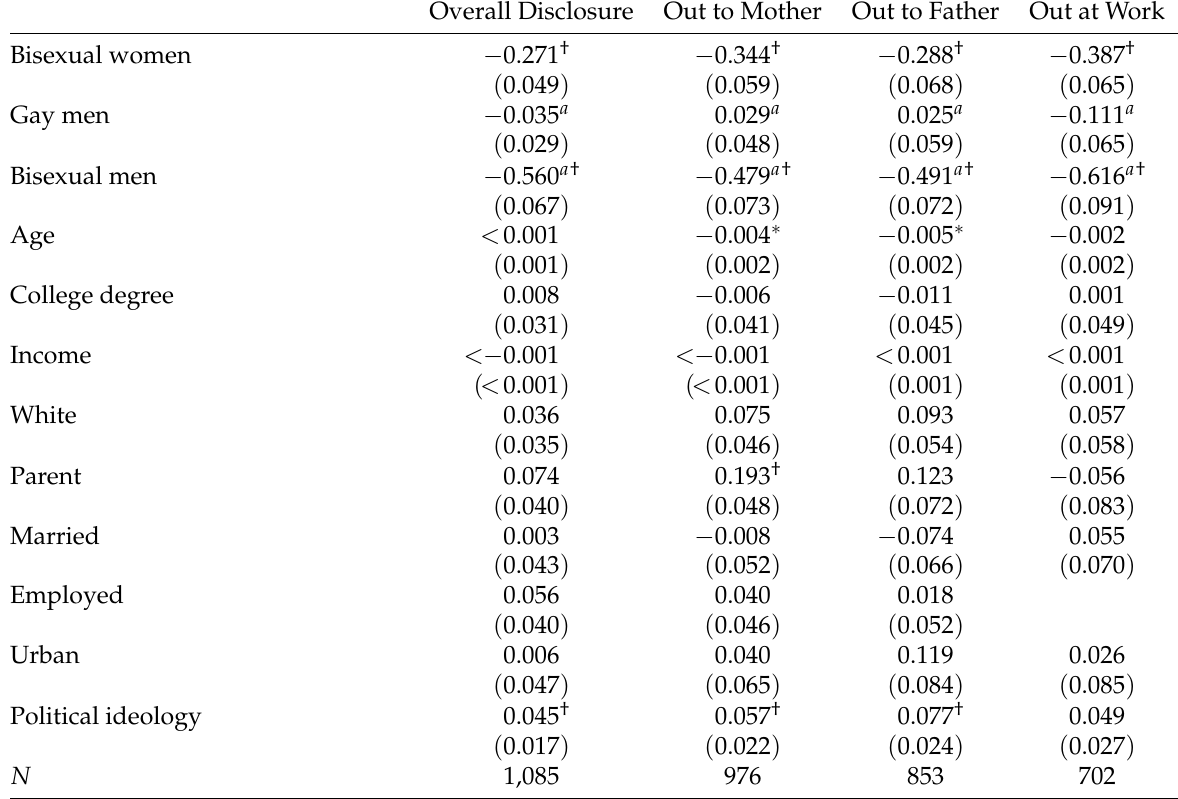
Table 3: Average marginal effects from binary logistic regressions of sexual identity disclosure on sexual identity group. Overall Disclosure Out to Mother Out to Father Out at